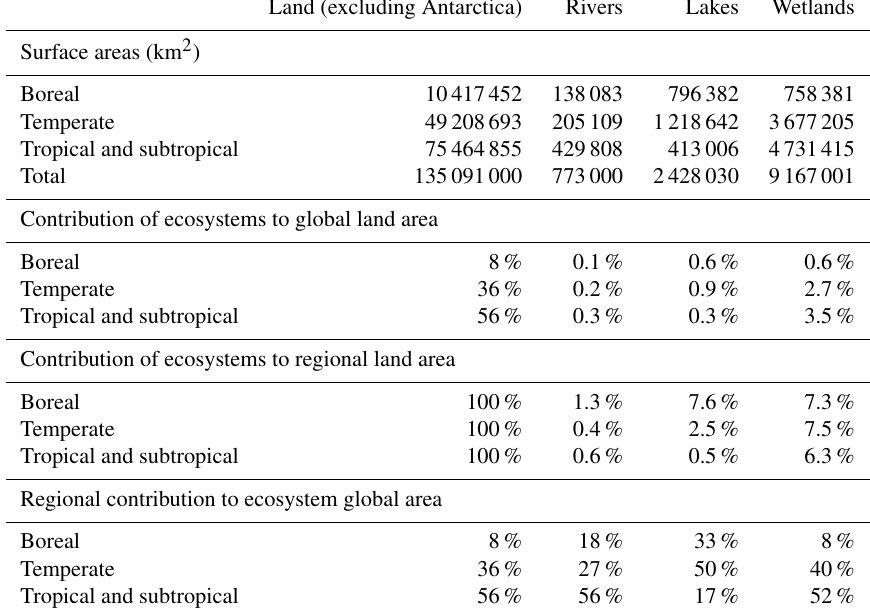
Table 1. Surface areas of land, rivers (from Allen and Pavelsky, 2018), lakes and wetlands (from Lehner and Döll, 2004). Boreal refers to latitudes higher than 66 ◦ N, temperate to latitudes between 34 and 66 ◦ N and between 34 and 66 ◦ S, and tropical and subtropical to latitudes between 34 ◦ N and 34 ◦ S. Note that the estimate of Downing (2009) gives larger surface areas for lakes and